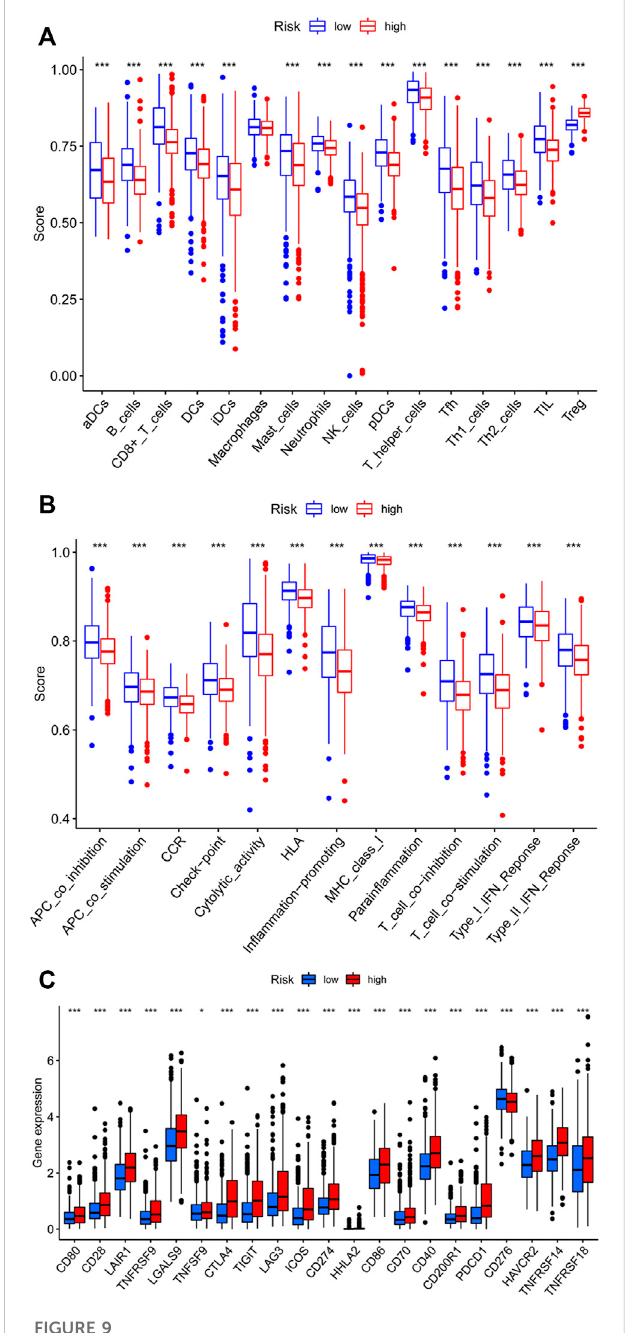
FIGURE 9 Assessment of Immune Cell In fi ltration, Immune Function Signature, andImmuneCheckpointGenesin Different riskGroups. (A) Differencesin thein fi ltrationofimmunecellsbetweenthehigh-andlow-riskgroups. (B) Differential expression levels of immune function signature between the high- and low-risk groups. (C) Differential expression of immune checkpoint genes between the high- and low-risk groups. ns, not signi fi cant, * p < 0.05, ** p < 0.01, *** p <